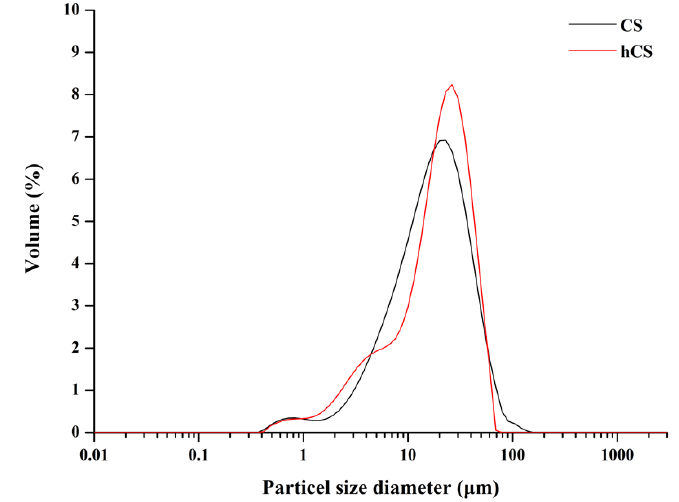
Figure 3. Particle size distribution of the non-hydrated CS powder (black line) and hydrated CS powder (red line) stored in distilled water.